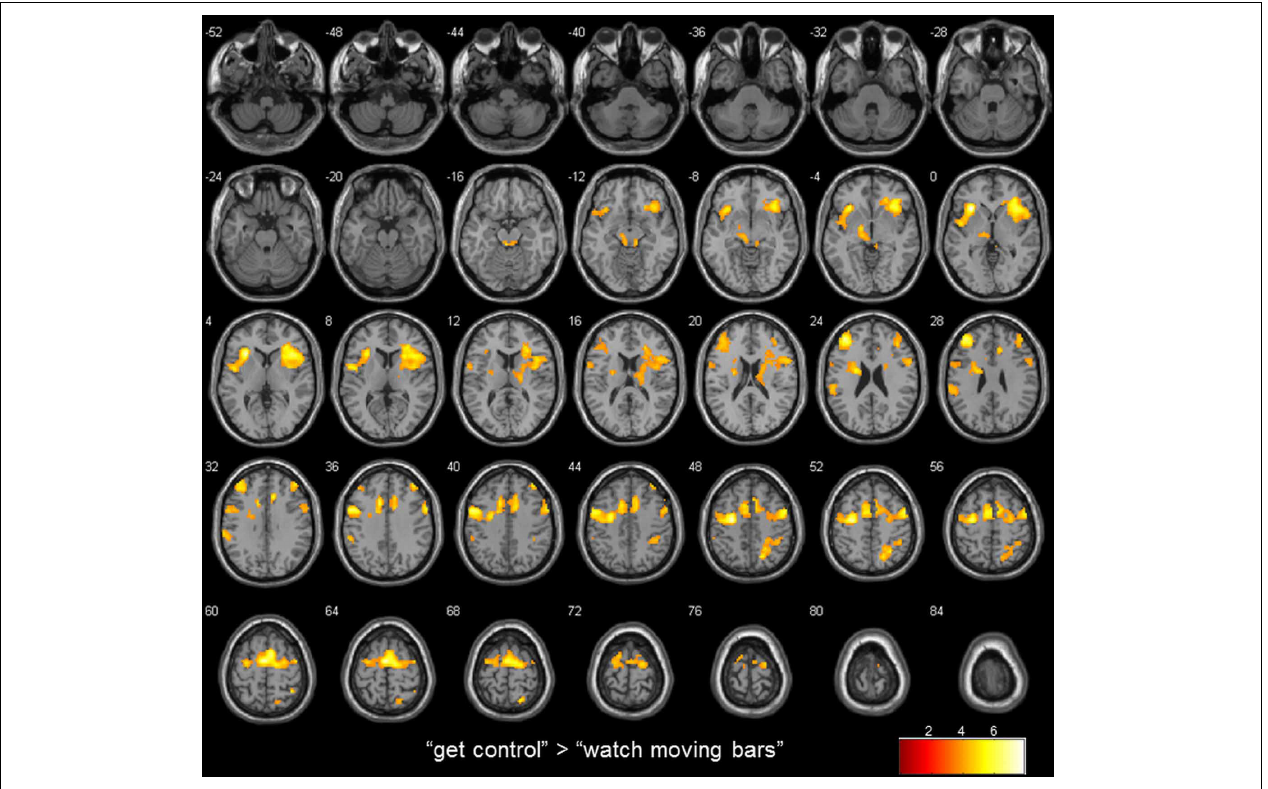
FIGURE 2 | transversal slices (4mm spacing); t-score map for “get control” “watch moving bars”; p < 0 . 001 uncorrected on voxel-level, p < 0 . 05 corrected for multiple comparisons on cluster-level [false discovery rate (FDR)]; minimum cluster size 10 voxels.